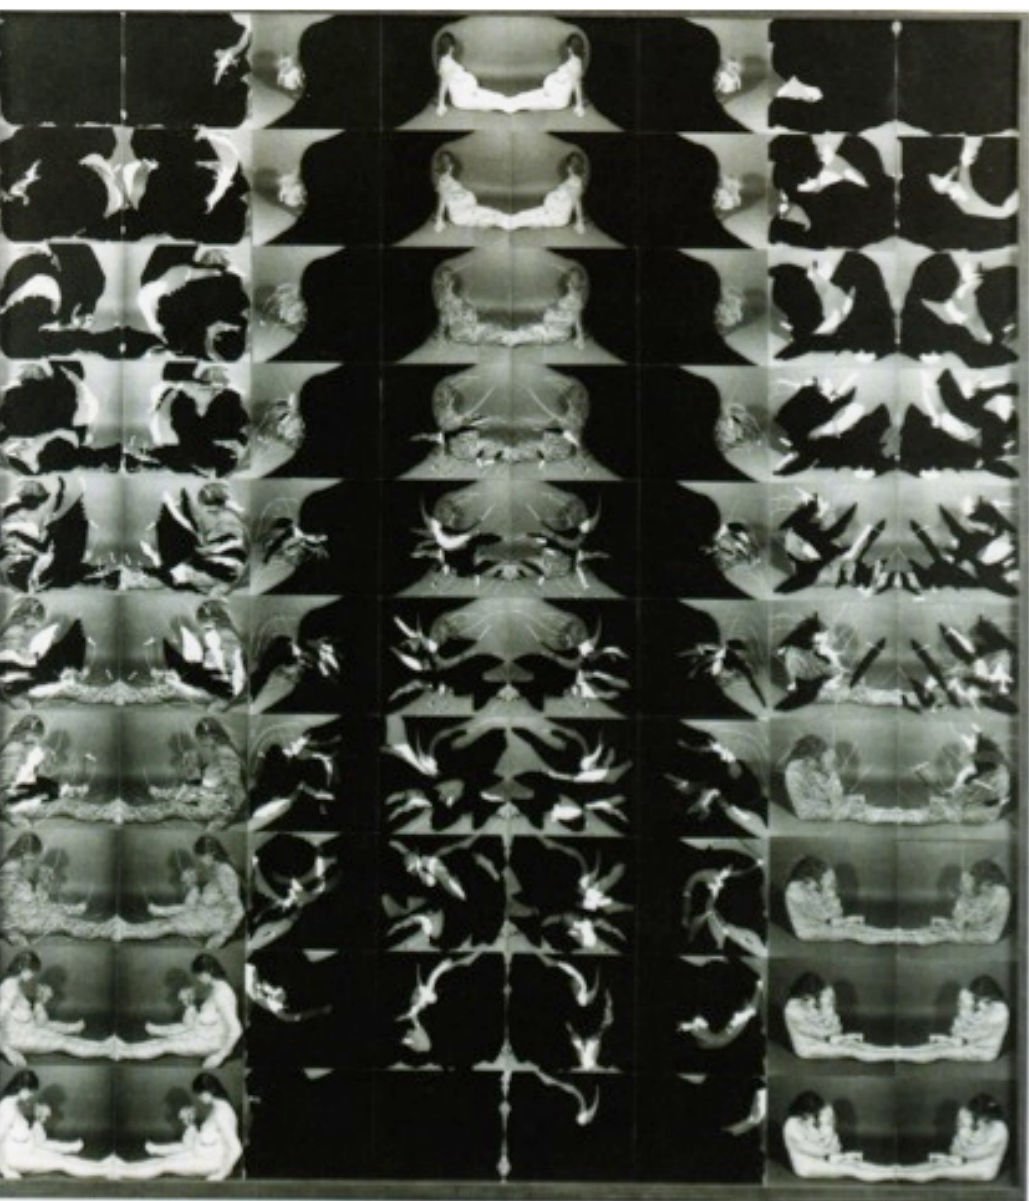
Heather Hanna, A Visual Essay: Interventions and Manipulations in the Maternal Studies in the Maternal, 4(1), 2012,